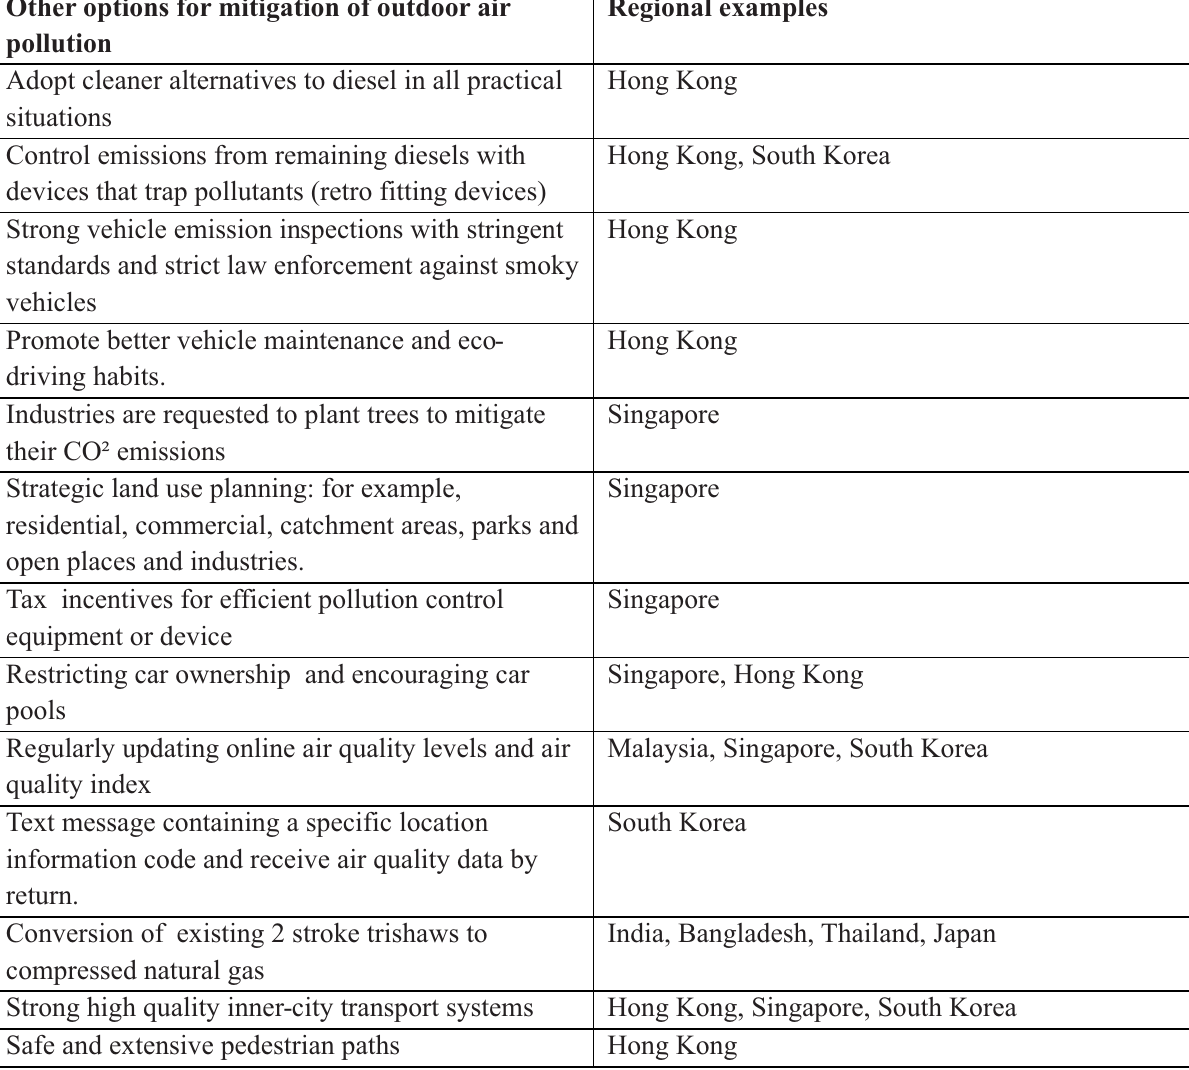
Table 6: Other outdoor air pollution mitigation options implemented in Asian countries Other options for mitigation of outdoor air